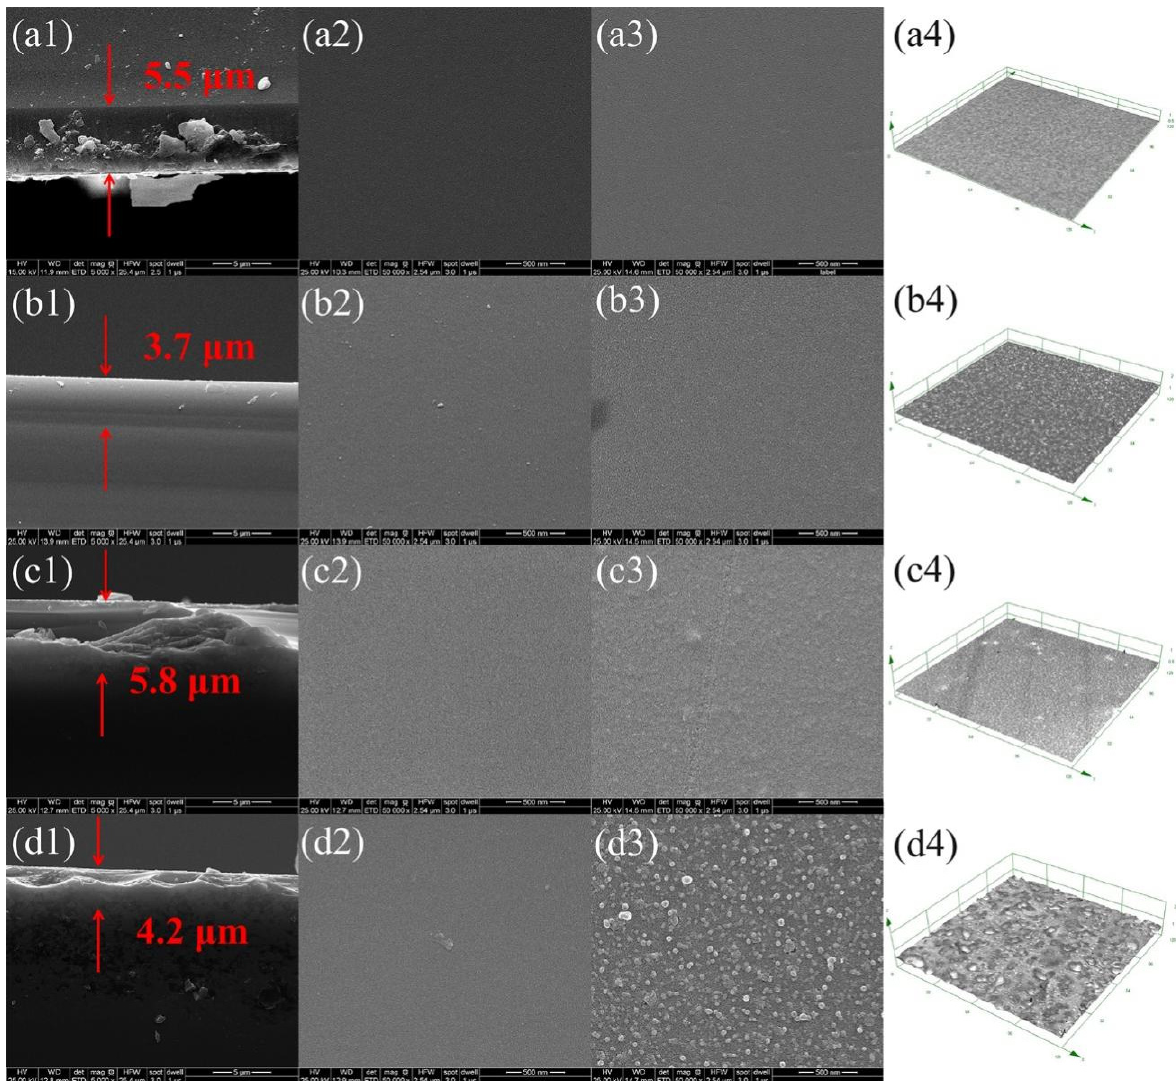
Figure 2. Images of FESEM and laser microscopy for the TiO 2 films ( a1 – a4 ) before and ( b1 – b4 ) after calcination, and for the keratin char-TiO 2 composite films ( c1 – c4 ) before and ( d1 – d4 ) after calcination (The numbers of 1, 2, 3 and 4 represent the cross-section, magnified cross-section and surface, and three-dimensional micrograph of the films, respectively).